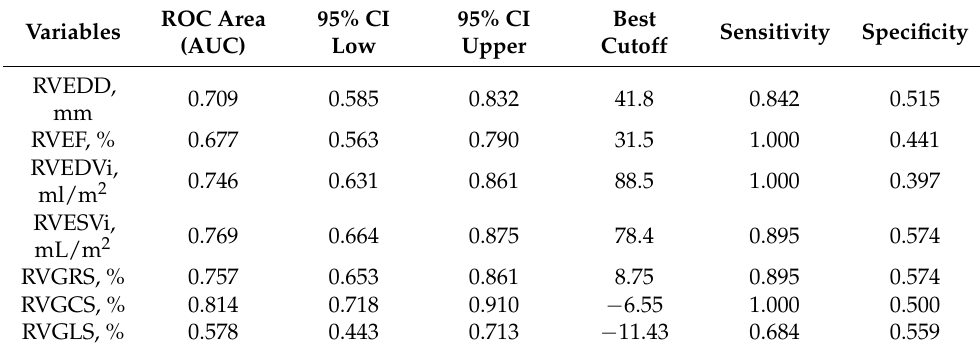
Table 3. Determinant factors of R wave amplitude after ICD implantation.